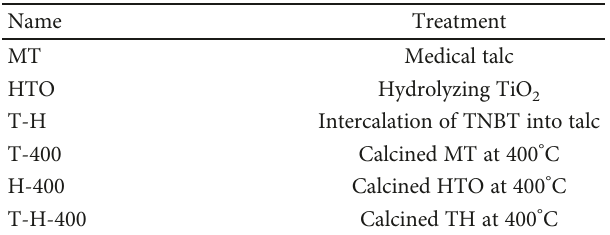
Table 1: The list of samples that were prepared during each stage.